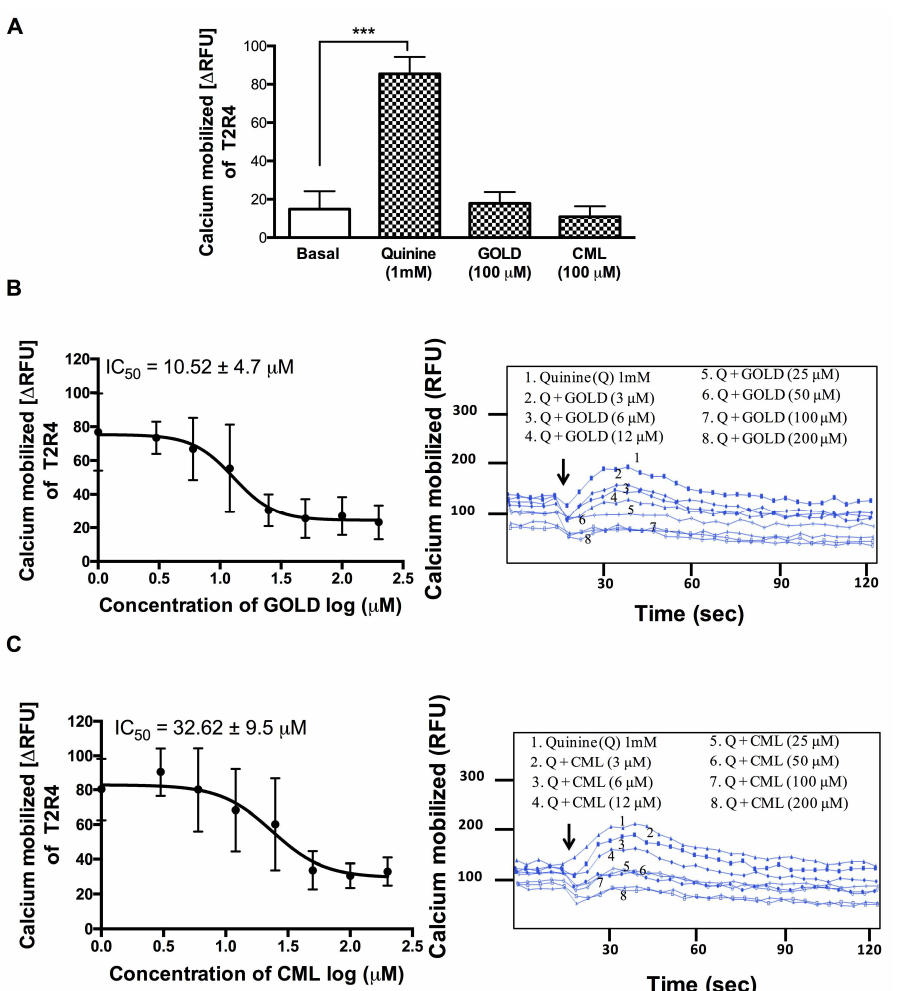
Figure 1. Calcium mobilization assays on T2R4 treated with AGE compounds. ( A ) HEK293T cells stably expressing T2R4 were treated with the AGE compounds, glyoxal-derived lysine dimer (GOLD) and carboxy methyl lysine (CML), at 100 µ M. Assay bu ff er (basal) and quinine (1 mM) were included as negative and positive controls, respectively. One-way ANOVA with Tukey’s multiple comparison post hoc test was performed to determine the statistical significance compared to the basal response. *** p < 0.001. The data was from three independent experiments in triplicates with error bars representing the standard deviation. ( B ) and ( C ). Concentration dependent responses of T2R4 expressing cells stimulated with 3–200 µ M of GOLD or CML in the presence of quinine (1 mM). Calcium mobilization reduced with the increase in GOLD and CML concentration, with an IC 50 of 10.52 ± 4.7 µ M and 32.62 ± 9.5 µ M, respectively ( ± standard deviation). Representative calcium traces of T2R4 expressed in HEK293T cells stimulated with quinine (Q), Q + GOLD, and Q + CML. Arrows indicate the time point (20 s) at which the ligands were